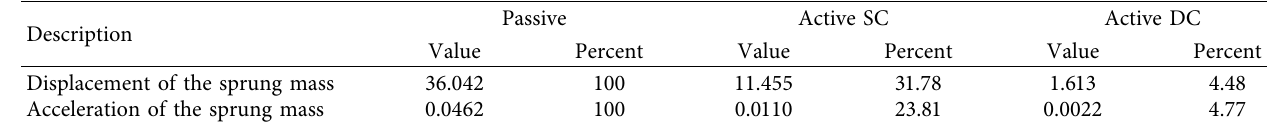
Table 6: The average value of case 2.